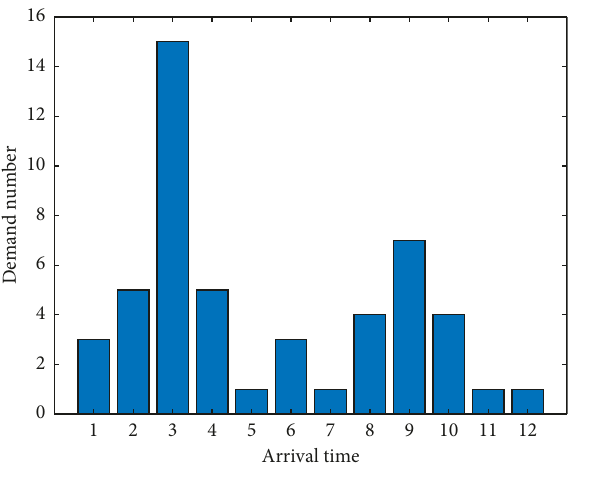
Figure 8: Parking demand distribution.